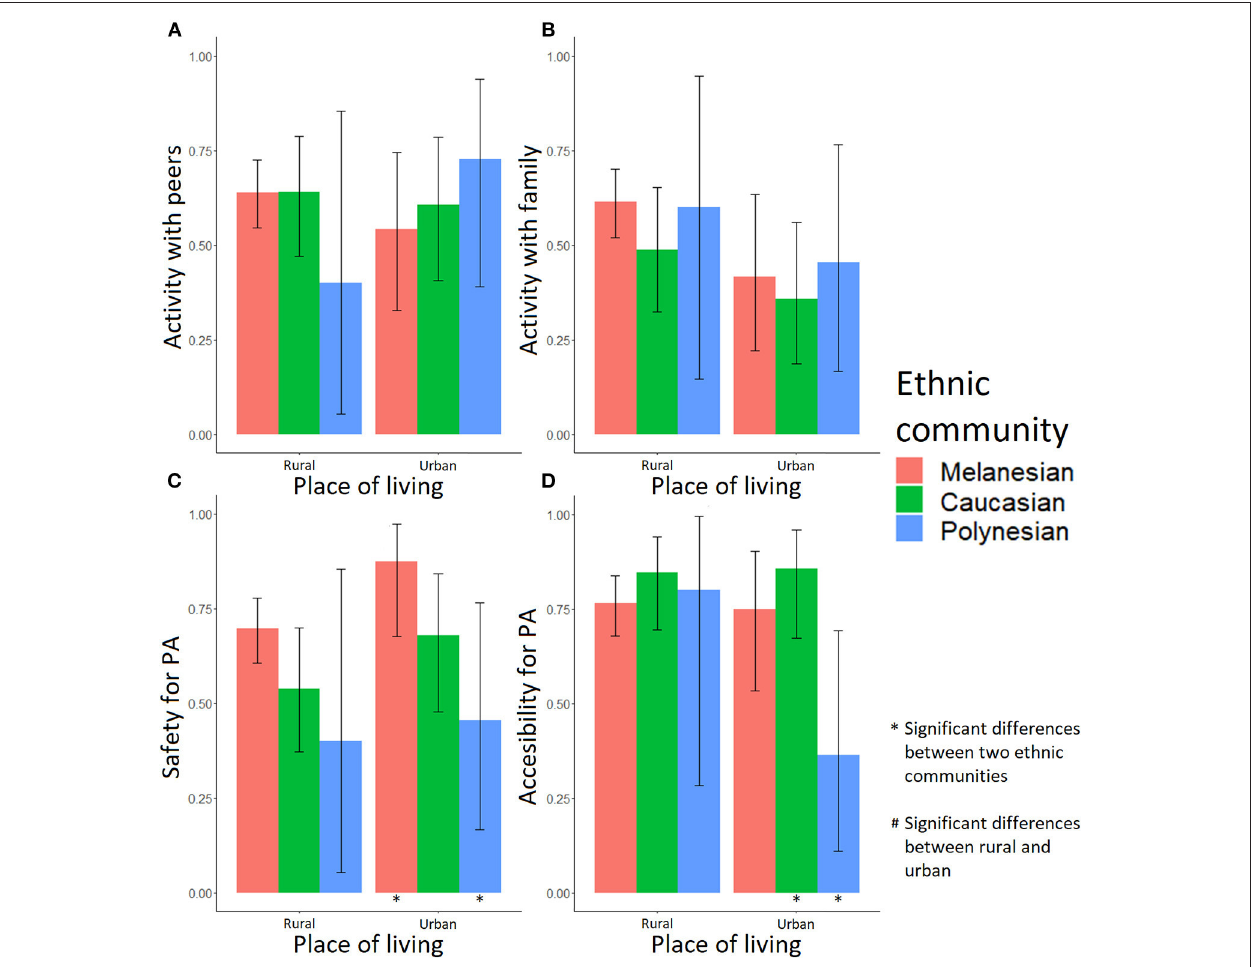
FIGURE 4 | Fractions of male adolescents for whom the socioenvironmental factors are important in PA practice. Activity: (A) with peers, (B) with family, (C) in safety, and (D) easy access. A “*” note means a significant difference between two ethnic communities in a single place of living; a “#” note means a significant difference between rural and urban environment in a single ethnic community.